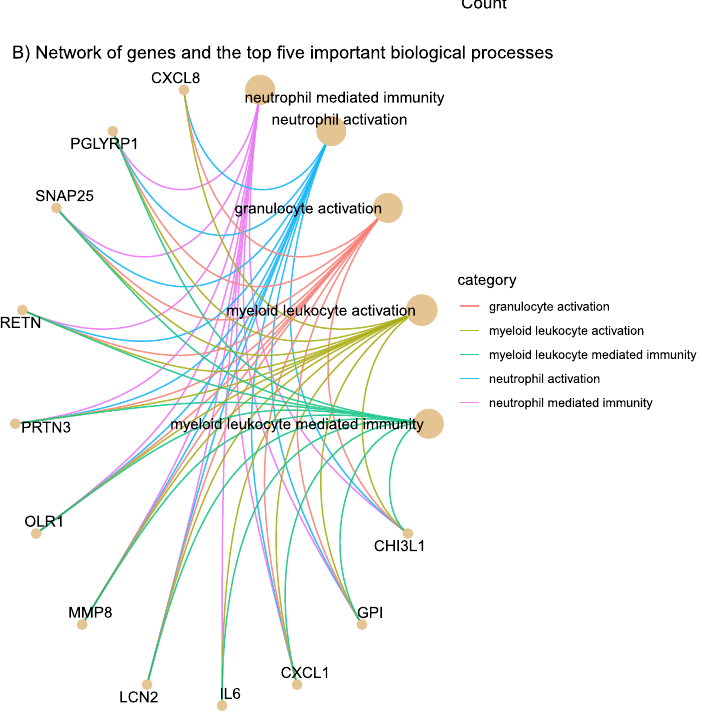
Figure 6. Gene ontology enrichment analysis of amniotic fluid proteins dysregulated with imminent delivery. Top 20 enriched biological processes ( A ) and a network representation of proteins involved in the top five enriched biological processes ( B ). Protein Ratio represents the number of proteins significantly dysregulated per the total number of proteins in a particular biological process. Darker red/blue indicate high/low enrichment, respectively. The size of the dots corresponds to the protein ratio represented by each biological